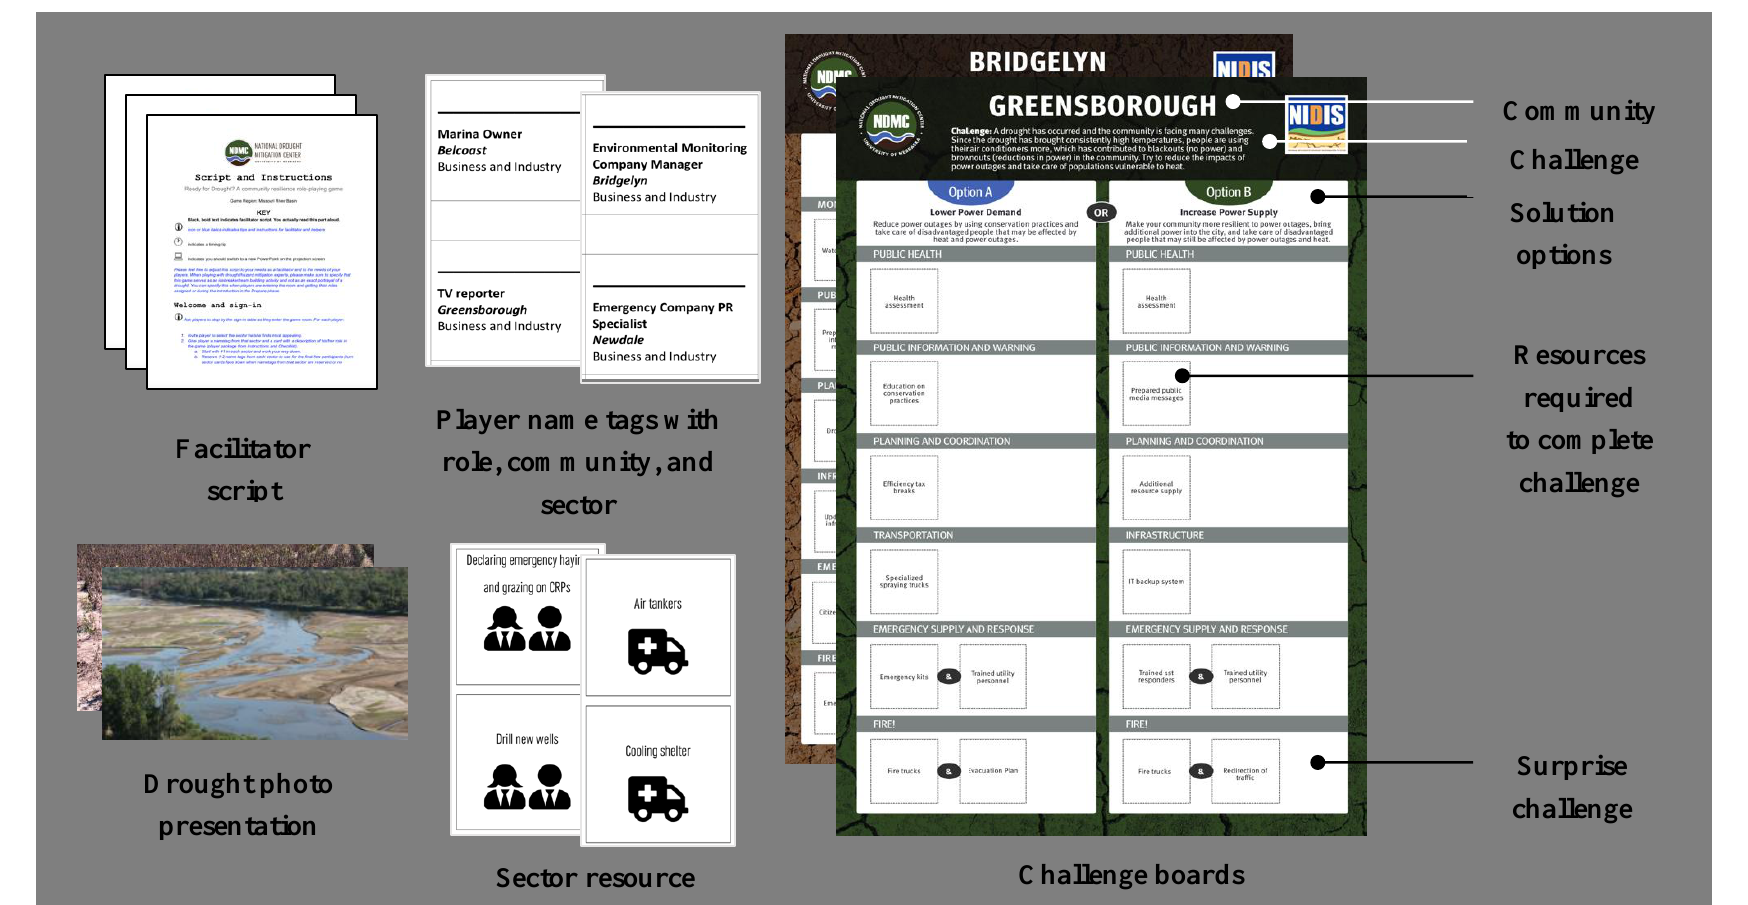
Figure 2. An example of the most important game package materials that are freely accessible and can be downloaded on the National Drought Mitigation Center website.